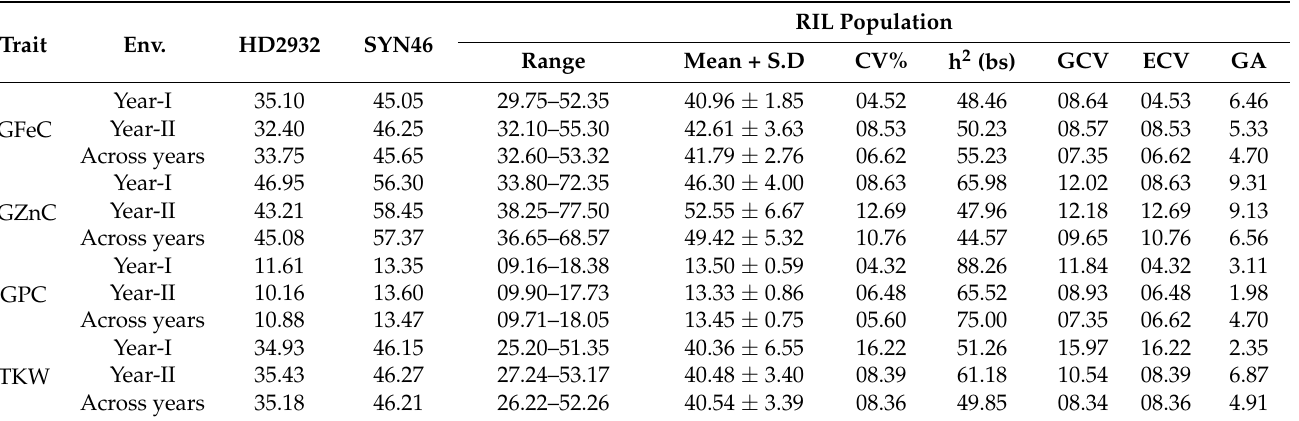
Table 1. Mean, heritability, and variance parameters of GFeC, GZnC, GPC, and